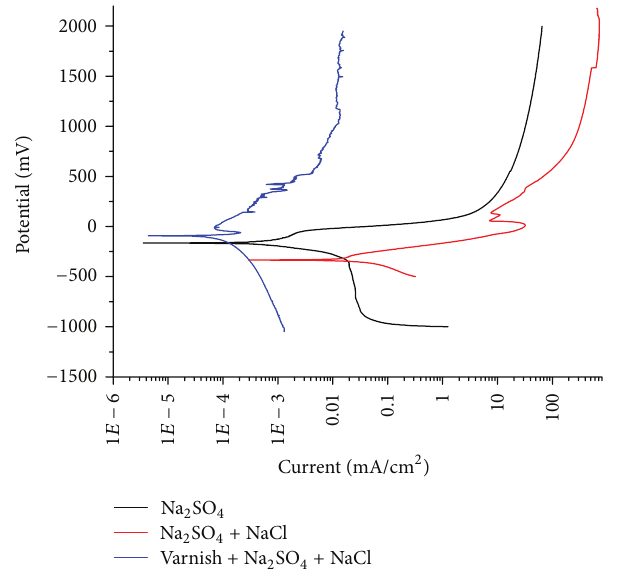
Figure 3: Polarization curves of blanks. Copper in Na 2 SO 4 solution, copper in Na 2 SO 4 + 3wt% NaCl solution, copper coated with varnish in Na 2 SO 4 + 3 wt% NaCl